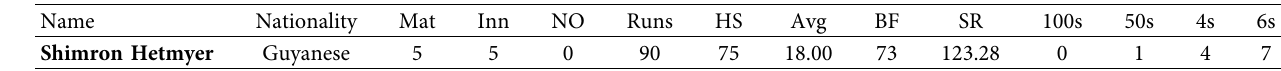
Table 17: New batsman to be added.